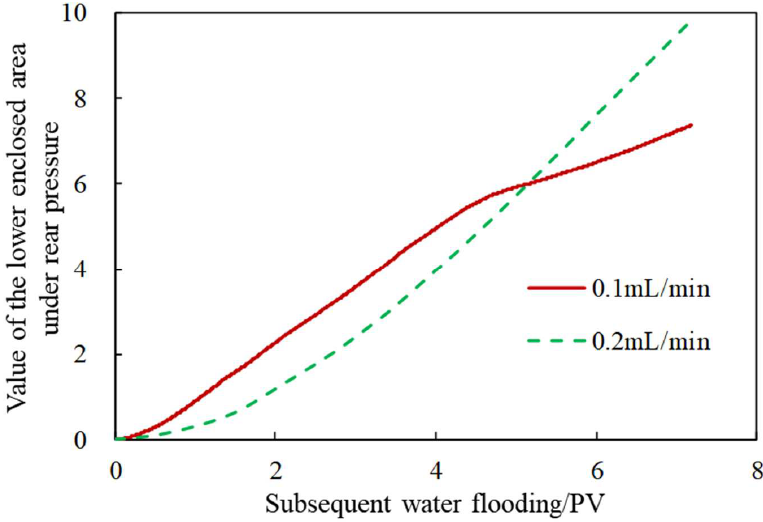
Figure 10. The value of the lower enclosed area under the rear pressure.